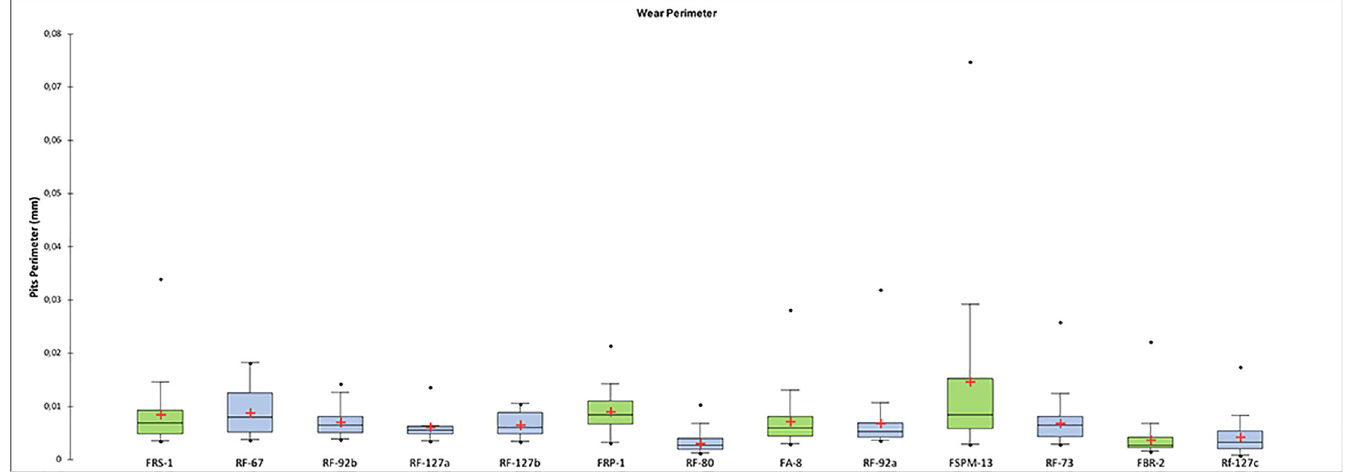
Fig 30. Comparison between the perimeters of the wear observed on the experimental = green, and archaeological = blue specimens.